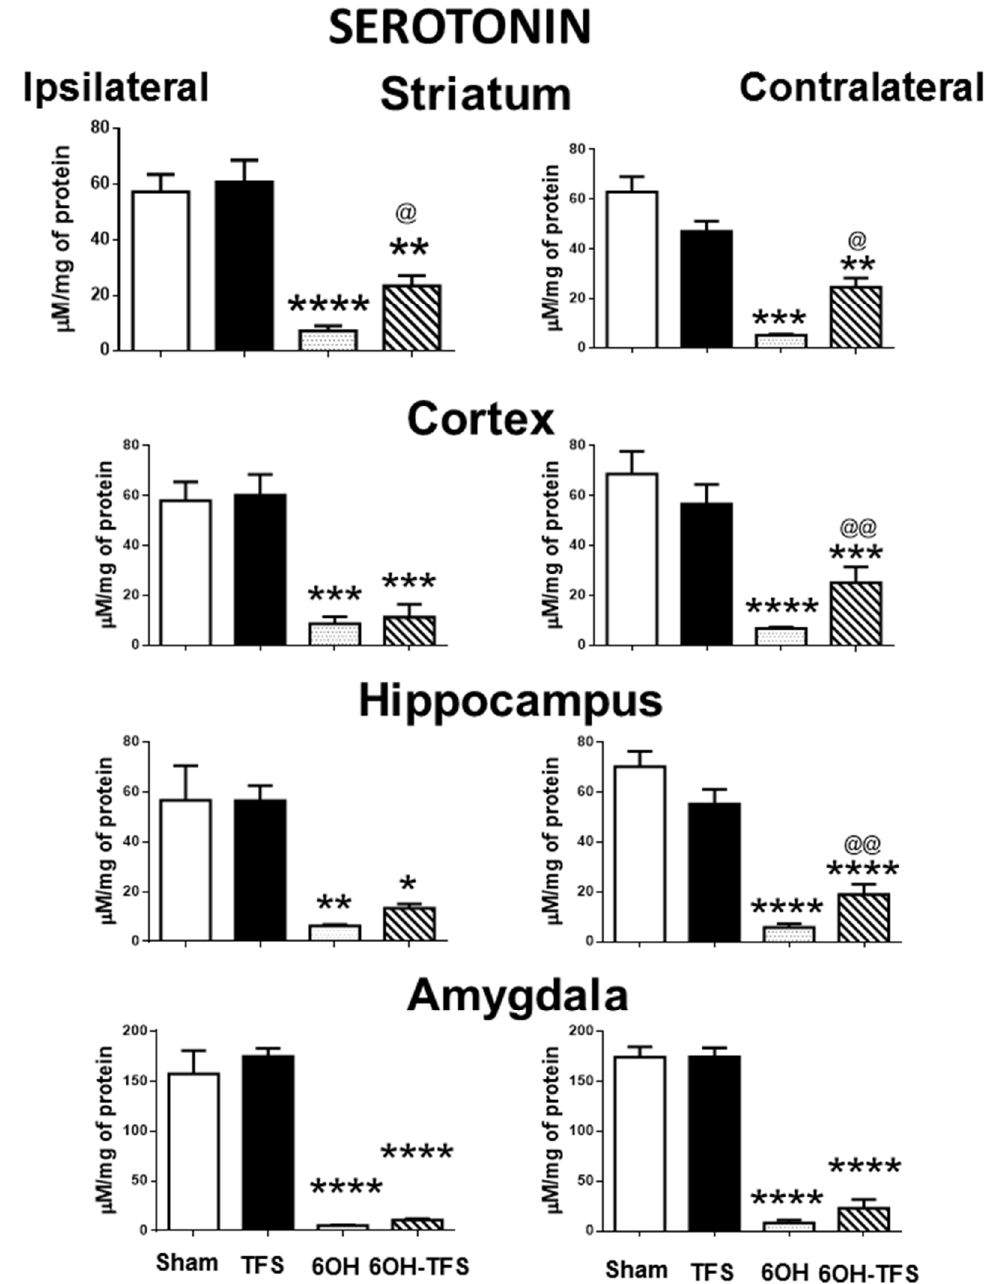
Figure 2. Effects of TFS on the changes in serotonin tissue content induced by 6-OHDA in different brain areas. Notations as in Figure 1. * p < 0.05 vs Sham group; ** p < 0.01 vs Sham group; *** p < 0.001 vs Sham group; **** p < 0.0001 vs Sham group; @ p < 0.05 vs 6-OHDA group; @@ p < 0.01 vs 6-OHDA group. The results obtained were analyzed with ANOVA followed by the post hoc Tukey test.